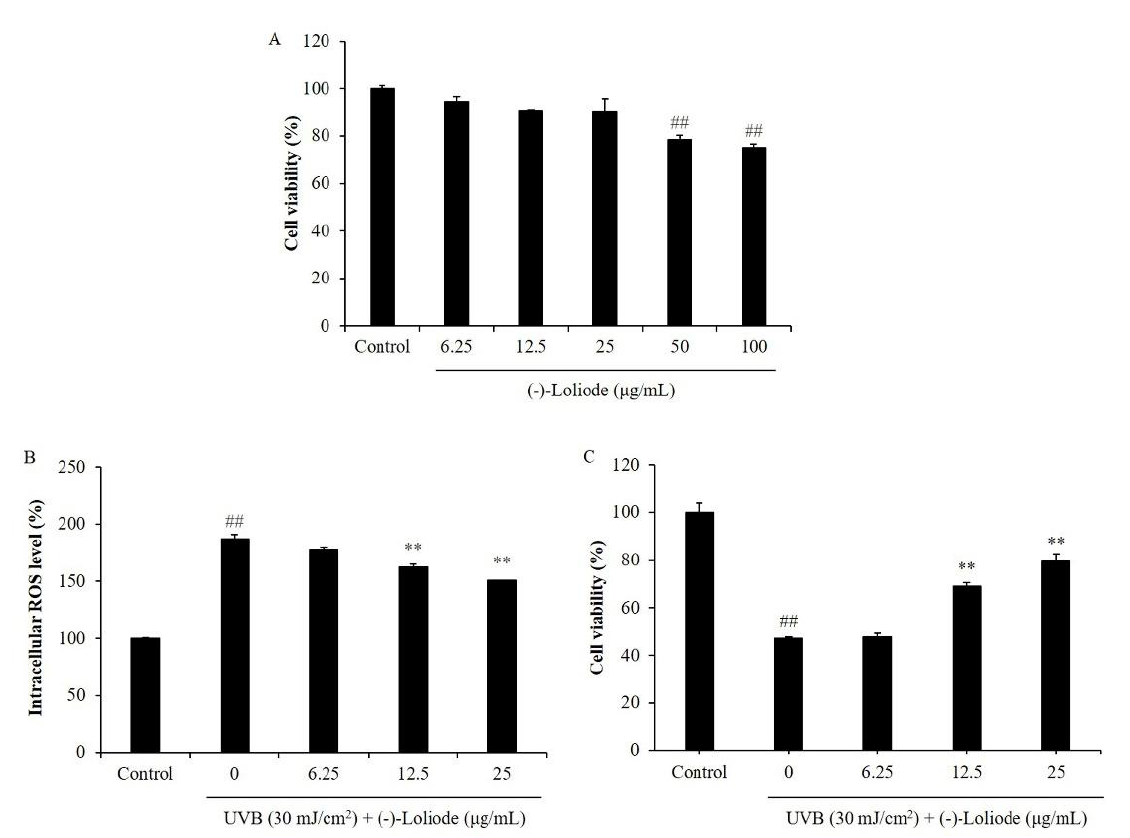
Figure 2. Protective effect of (-)-loliode against UVB-induced HaCaT cell damage. ( A ) Cytotoxicity of (-)-loliode on HaCaT cells; ( B ) intracellular ROS scavenging effect of (-)-loliode in UVB-irradiated HaCaT cells; ( C ) protective effect of (-)-loliode on UVB-induced cell death in HaCaT cells. Cell viability was measured by the MTT assay and intracellular ROS levels were measured by the DCF-DA assay. The data was expressed as the mean ± SE (n = 3). ** p < 0.01 as compared to the UVB-irradiated group and ## p < 0.01 as compared to the control group.